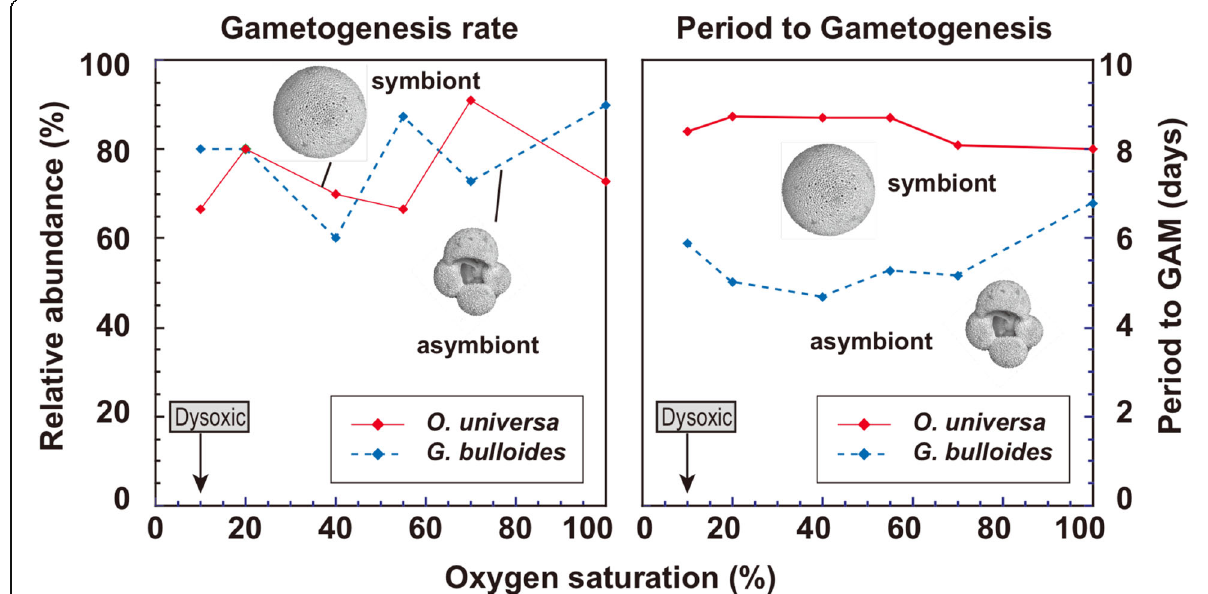
Fig. 15 Gametogenesis rates (left) and days to gametogenesis (right) in Orbulina universa (solid red line) and Globigerina bulloides (broken blue line) at different dissolved oxygen (DO) saturation levels (figure modified from Kuroyanagi et al. 2013). Although DO environments are classified differently in different studies (e.g., Jorissen et al. 2007), a DO of 10% (~ 0.7 mg O 2 L − 1 or ~ 22 mmol O 2 m − 3 ) was generally classified as “ dysoxic